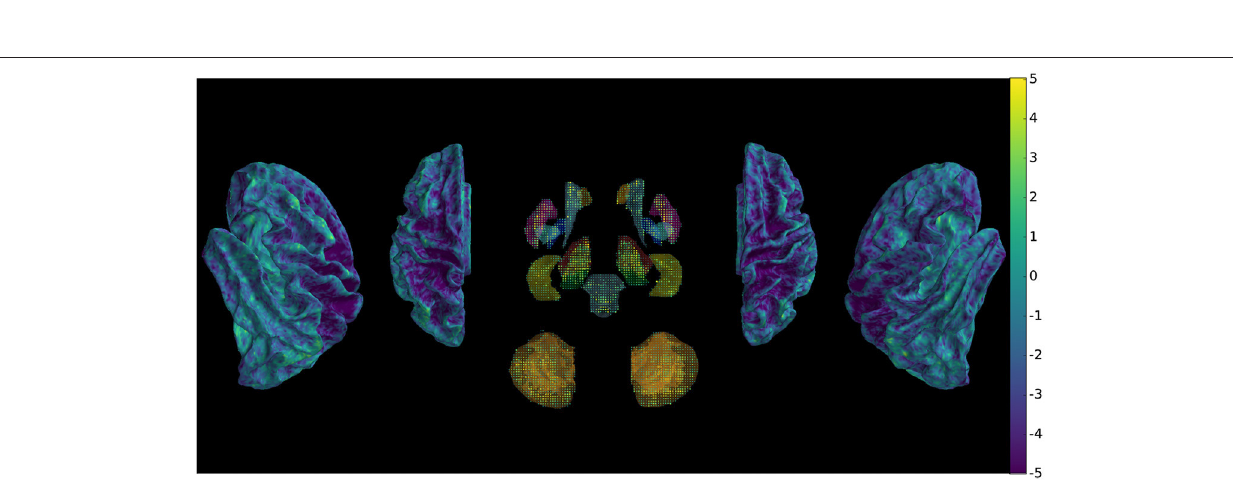
FIGURE 5 | Comparison of signal variability between new and conventional preprocessing using a paired t -test across subjects and scans, showing overall decrease of rapid non-physiologically plausible signal changes.